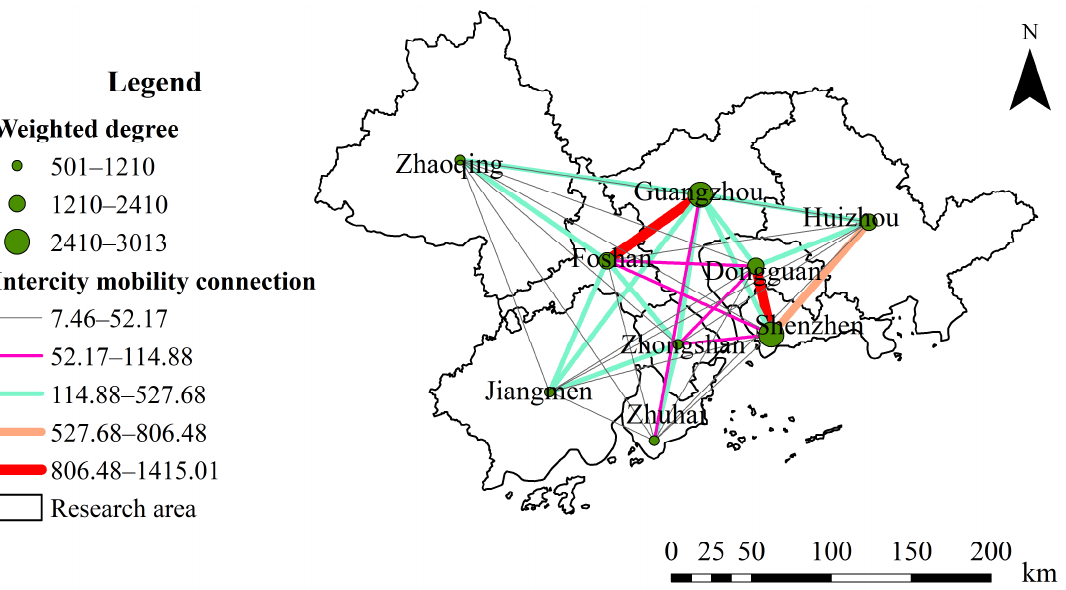
Figure 3. The ‘Core-Periphery’ differentiation of the GBA.